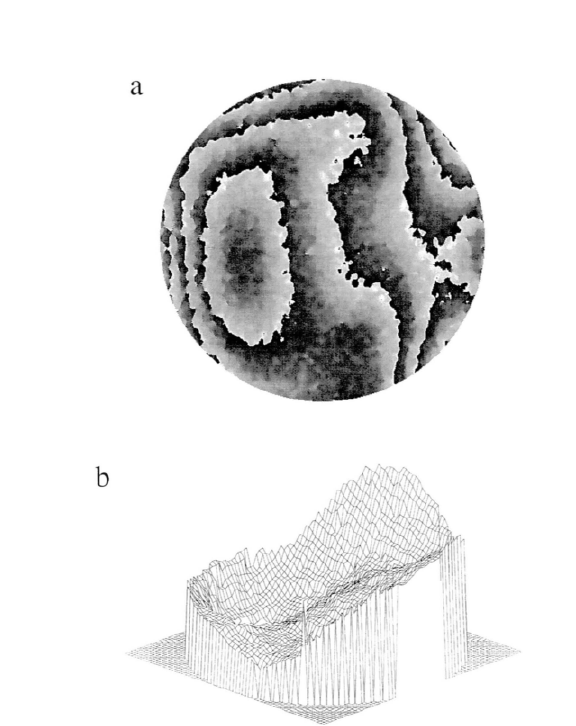
FIGURE 10 Double-pulse speckle interferometry with a plate rotating at 3000 rpm. pulse separation 200 f.1.s: (a) phase map and (b) pseudo-3-D representation of the